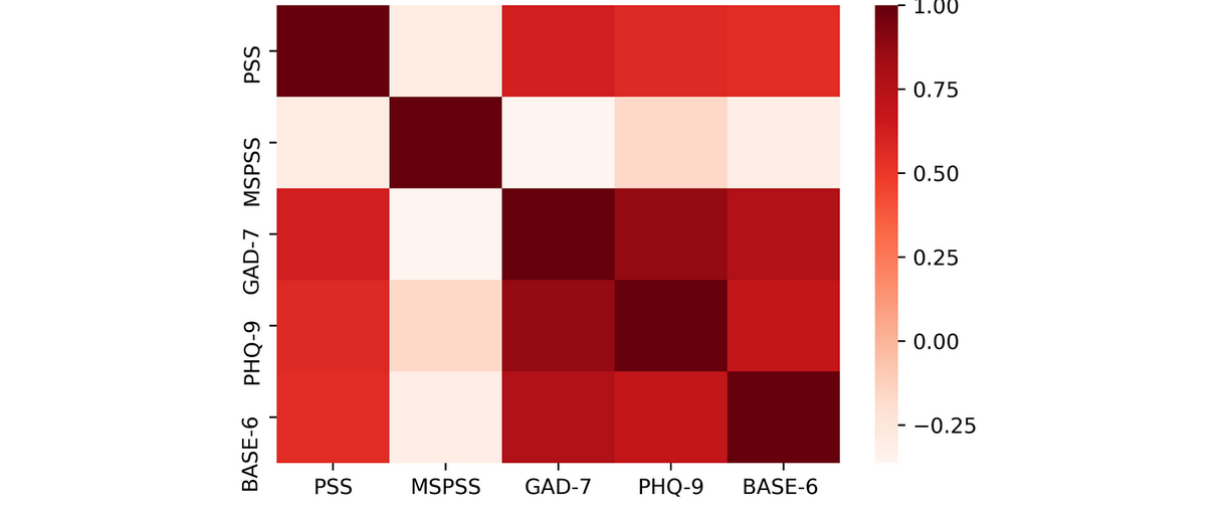
Figure 1. Heat map of correlations between the survey scale scores. BASE-6: Brief Adjustment Scale-6; GAD-7: Generalized Anxiety Disorder